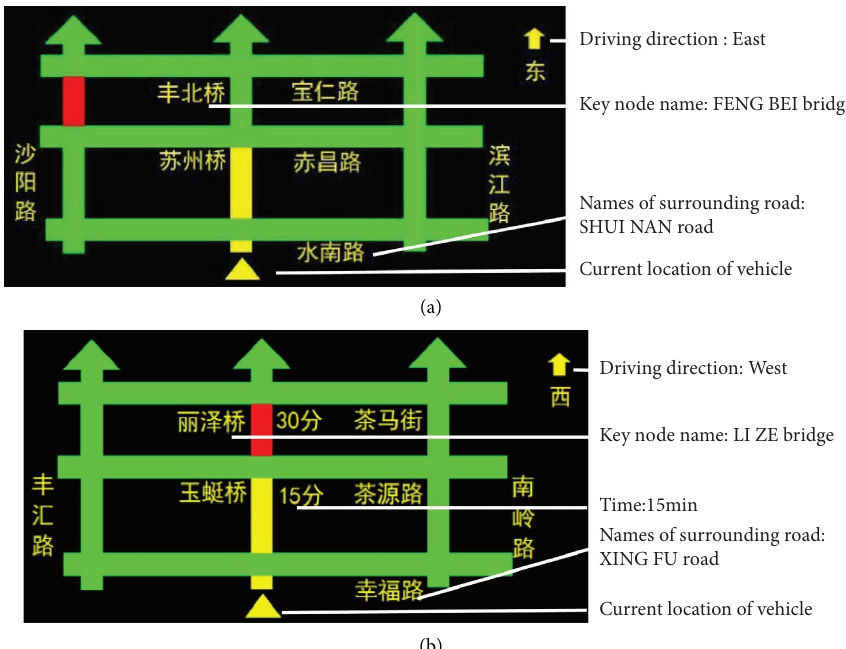
Figure 5: Control and experimental groups of VMSs (taking 6 roads as examples). (a) Te control group (without auxiliary information). (b) Experimental group (with auxiliary